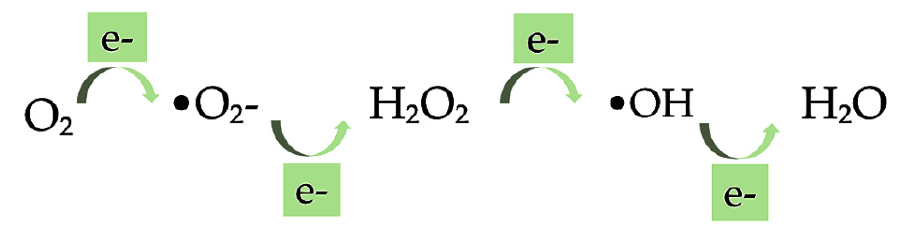
Figure 5. Formation of superoxide radical ( • O 2 − ), hydrogen peroxide (H 2 O 2 ), hydroxyl radical